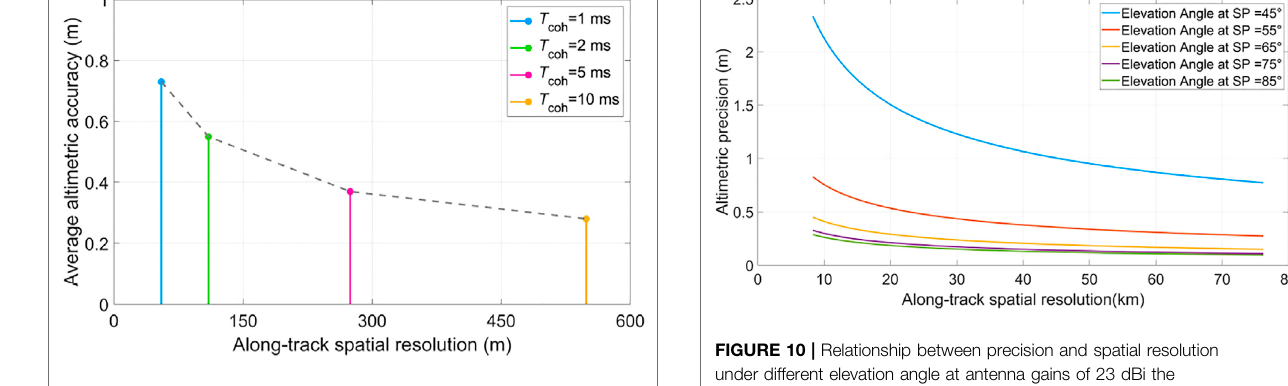
FIGURE 8 | Altimetric accuracy as a function of along-track spatial resolution under the airborne scene.